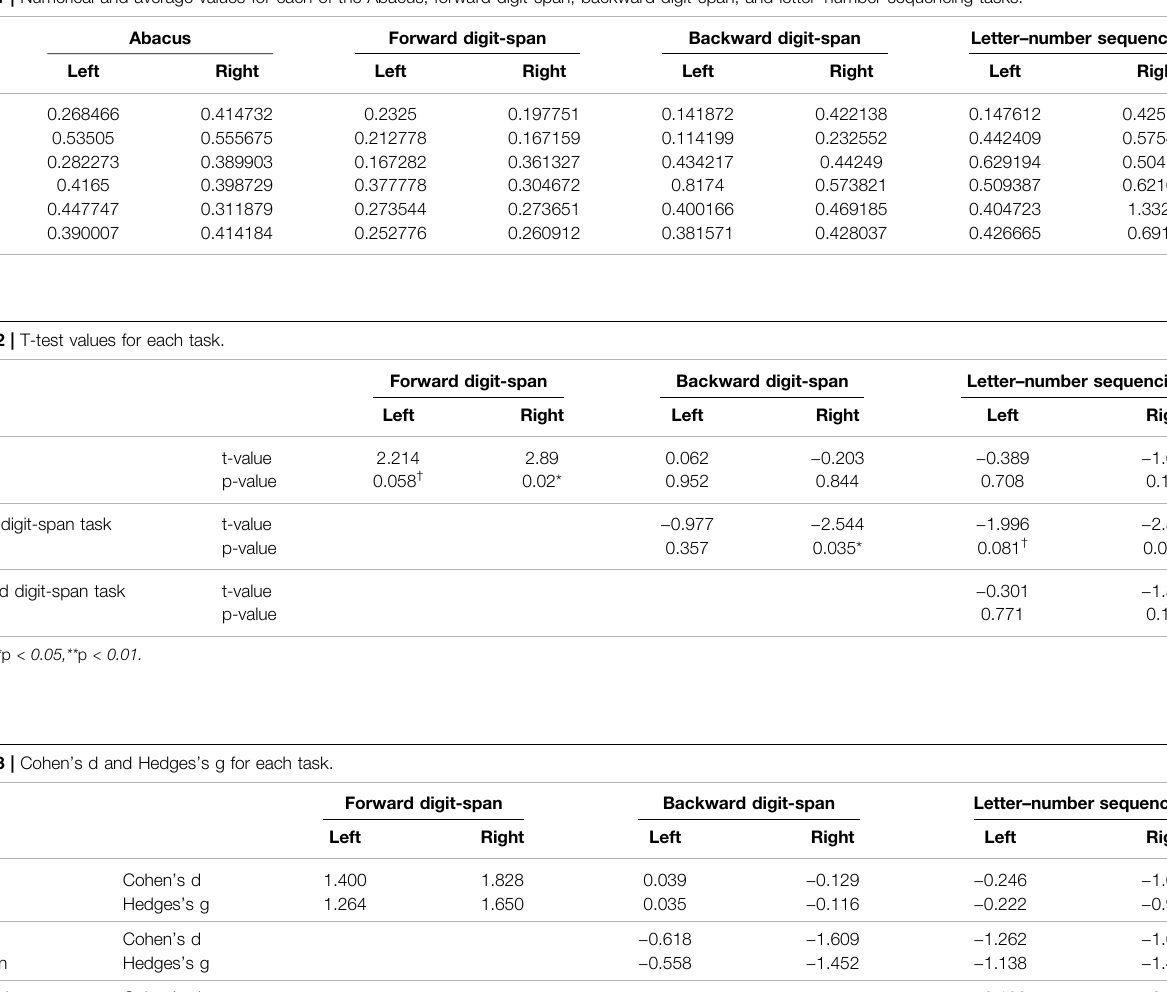
TABLE 1 | Numerical and average values for each of the Abacus, forward digit-span, backward digit-span, and letter – number sequencing tasks.